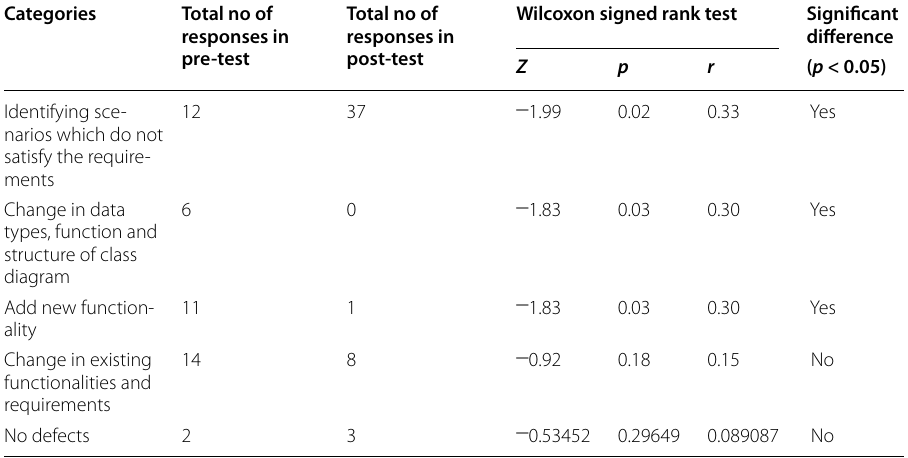
Table 3 Differences between pre-test and post-test in student responses to identifying defects